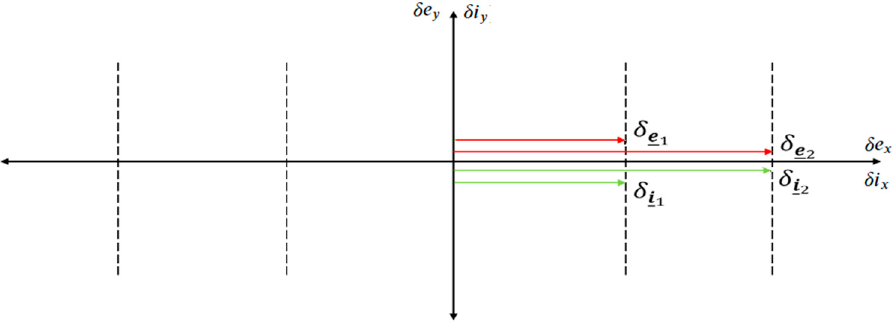
(in red) and relative inclination 𝛿 (cid:3036)